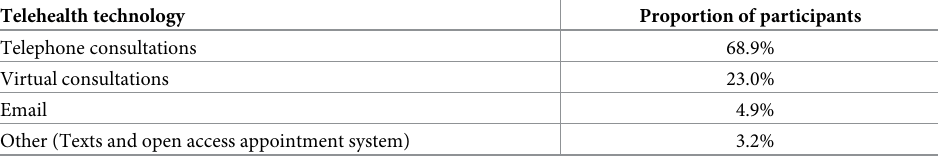
Table 5. Physicians’ perception on the sustainable use of telehealth technology in their primary care practice post-pandemic ( n =